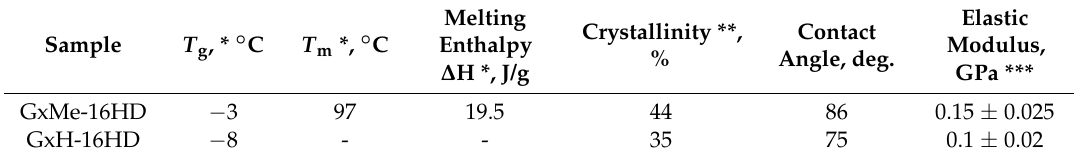
Table 2. Overview of the thermal and mechanical behaviour of the two galactarate acetalised polyesters.